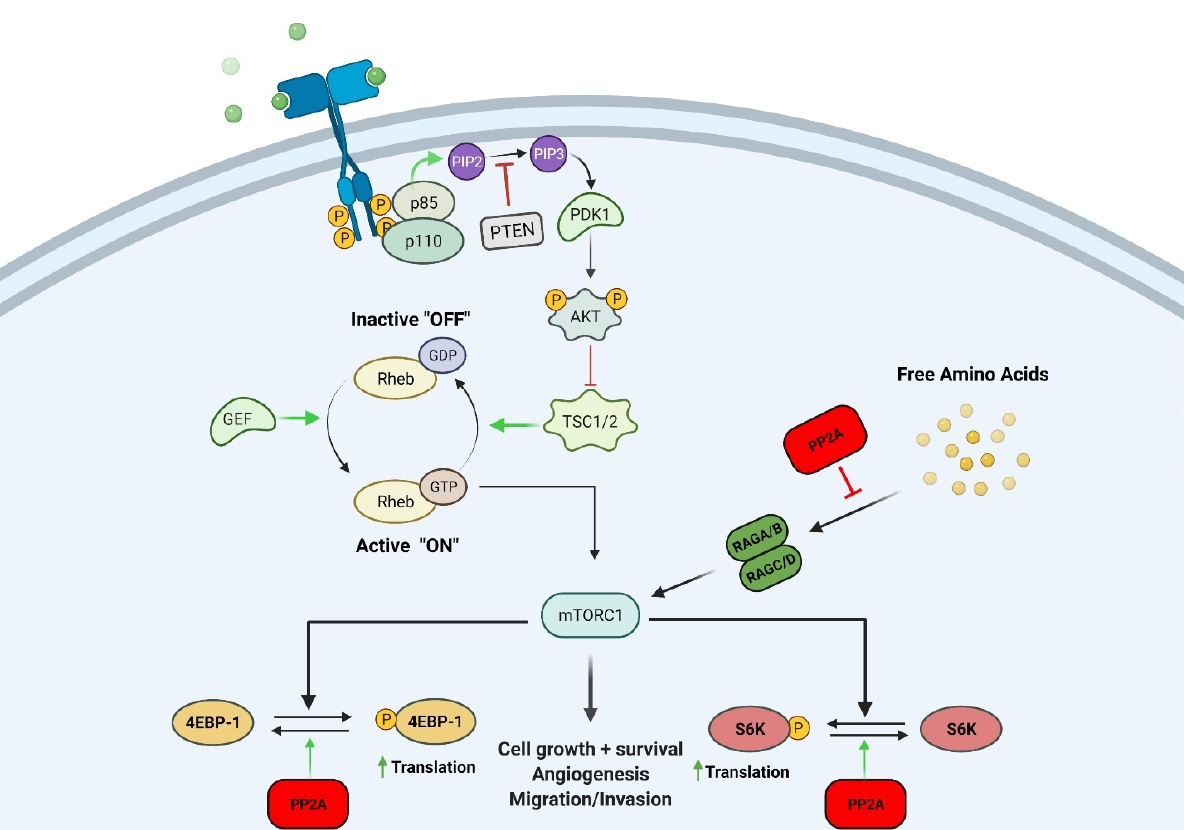
Figure 1. Schematic representation showing the mechanism in which PP2A can negatively regulate the mTOR pathway. PP2A can inhibit mTOR effectors 4EBP-1 and S6K by reversing their phosphorylation state. PP2A can also inhibit nutrient signaling to RAG complex proteins thereby inhibiting the mTOR pathway. Figure created with